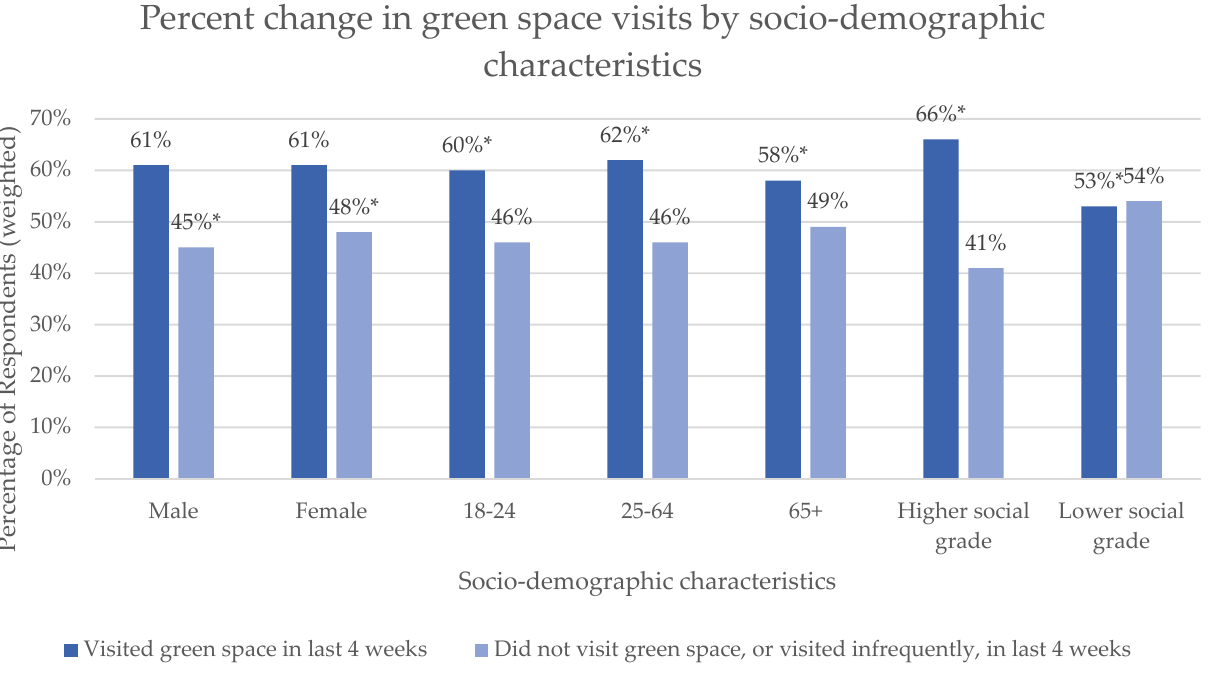
Figure 2. Change in the percentage of respondents stating visits to green space by socio-demographic characteristics (* Chi 2 p -values < 0.05).